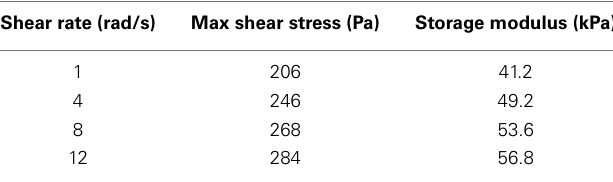
Table 5 | Storage modulus and maximum shear stress of MRSSE under different shear rate .